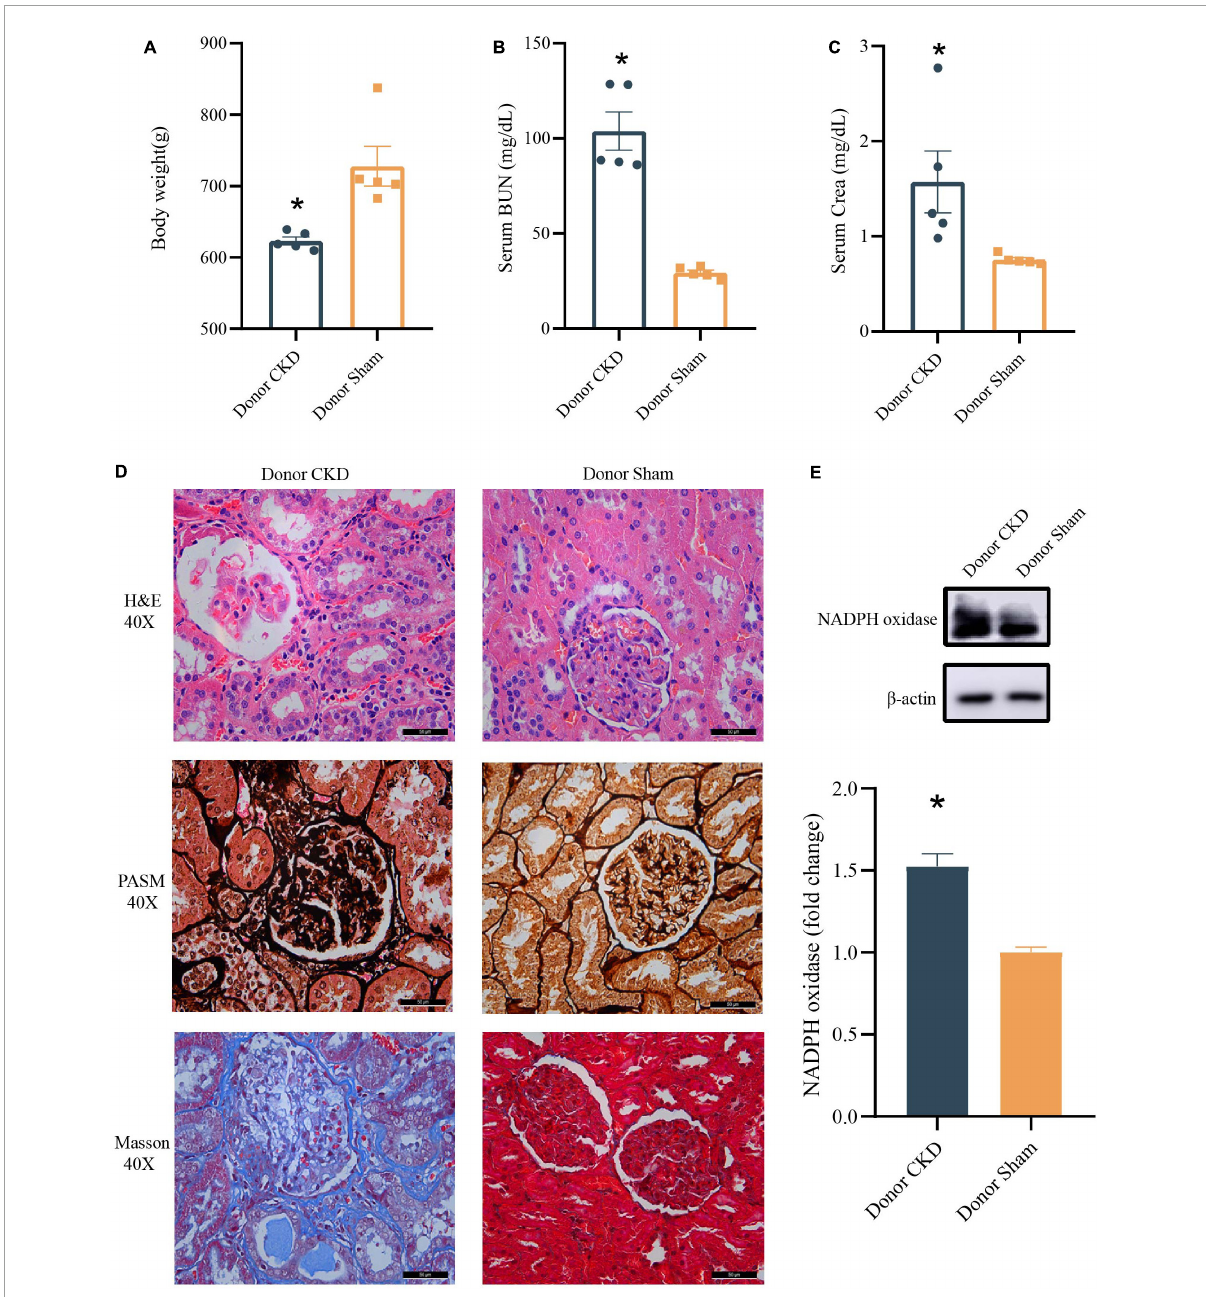
FIGURE2 Changes in various indicators after successful establishment of a kidney disease model. (A) Body weight. (B) BUN. (C) Crea. (D) Histology of kidney tissue stained with H&E, PASM, and Masson. (E) Western blot results for NADPH oxidase. The data is presented as means ± SEM. Donor Sham, n = 5; Donor CKD, n = 5. * p <